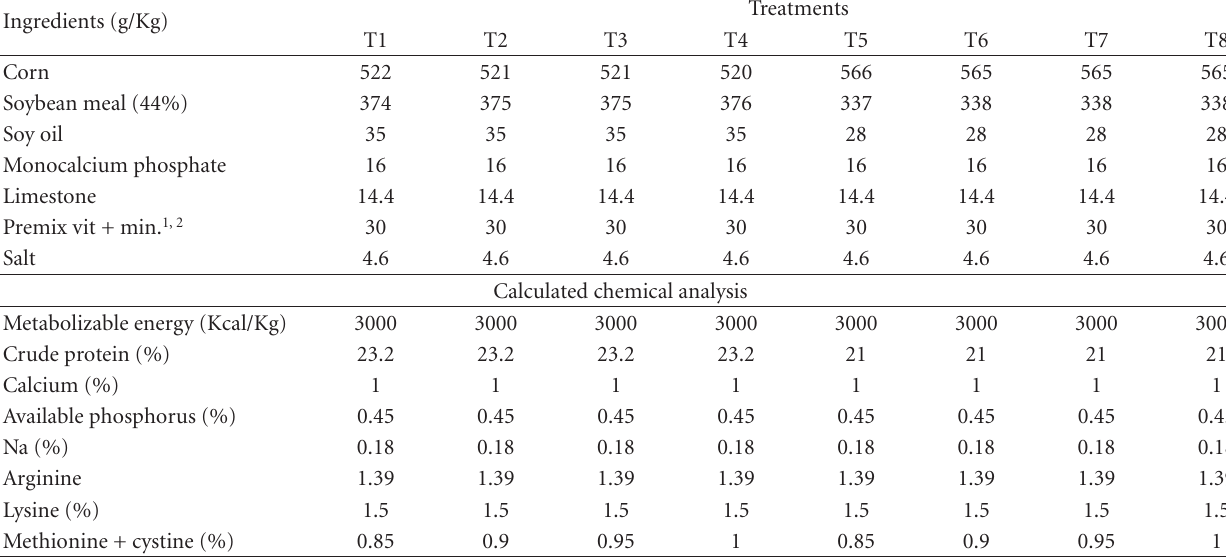
Table 2: The composition and calculated chemical analysis of diets in Experiment